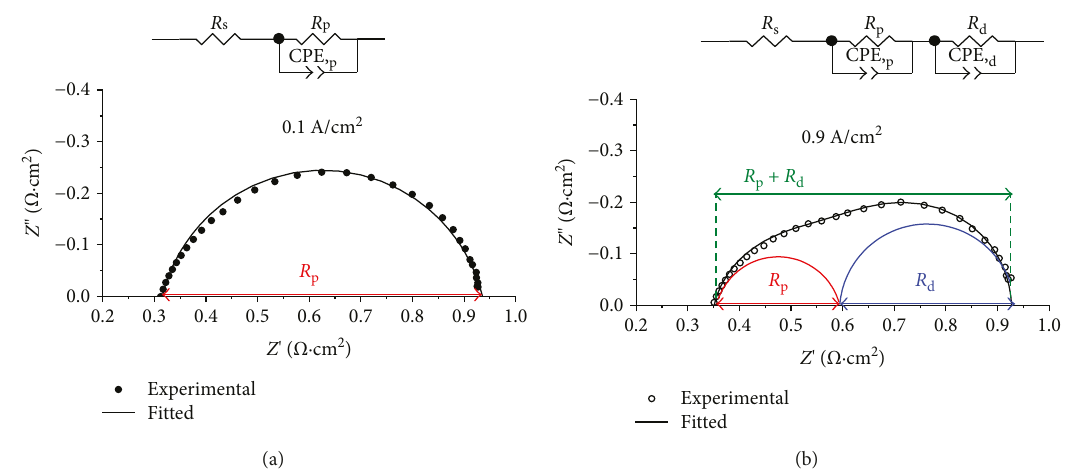
Figure 7: An example of modeling: equivalent circuits at low current density (a) and at high current density (b) for two spectra obtained for sample GDE2 anode at low inlet gas fl ow rate. R procedure was obtained.